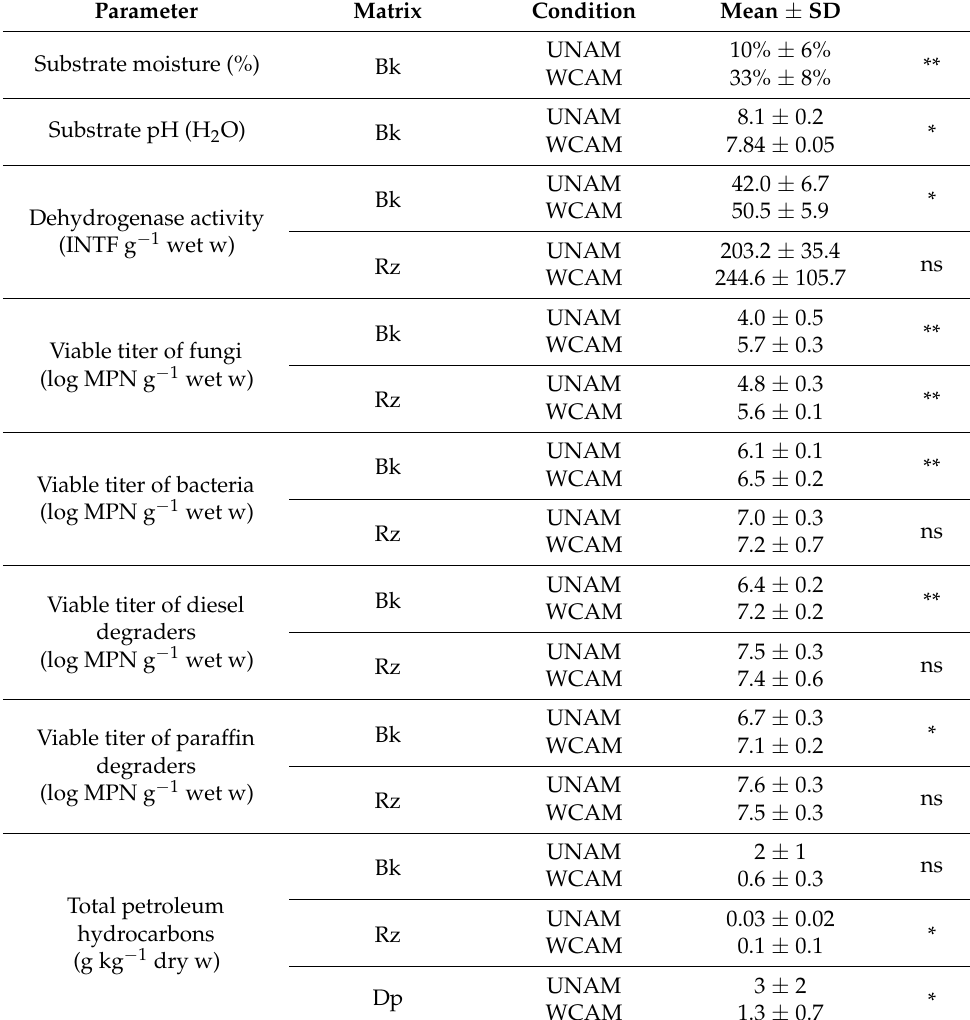
Table 2. Effect of wood chips on the properties of the bulk substrate (Bk), rhizosphere substrate (Rz) and deep substrate (Dp) at the end of the phytoremediation test with Helichrysum microphyllum subsp. tyrrhenicum in the refinery substrate with aged contamination unamended (UNAM) and amended (WCAM) with wood